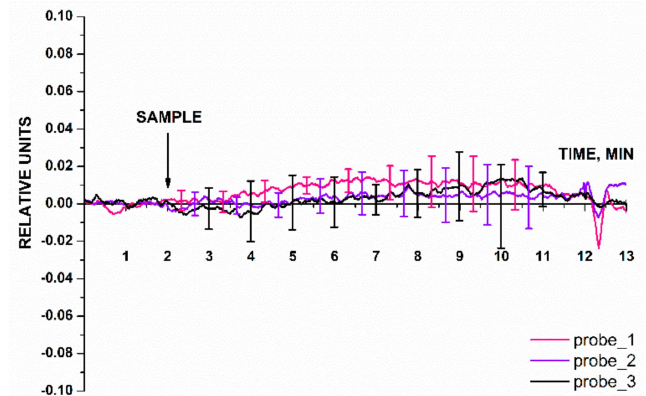
Figure 8. Typical sensorgram curves recorded in the blank experiments, in which the oDNA-free buffer was added into the measuring cell instead of target oDNA solution. Experimental conditions: nanowires with immobilized oDNA probes (probe_1, probe_2, and probe_3); 1 mM PPMB; V g = 50 V, V ds = 0,2 V; solution volume in the measuring cell was 450 µ L. Number of technical replicates, n = 5. The arrow indicates the time point when the buffer under study (SAMPLE) was